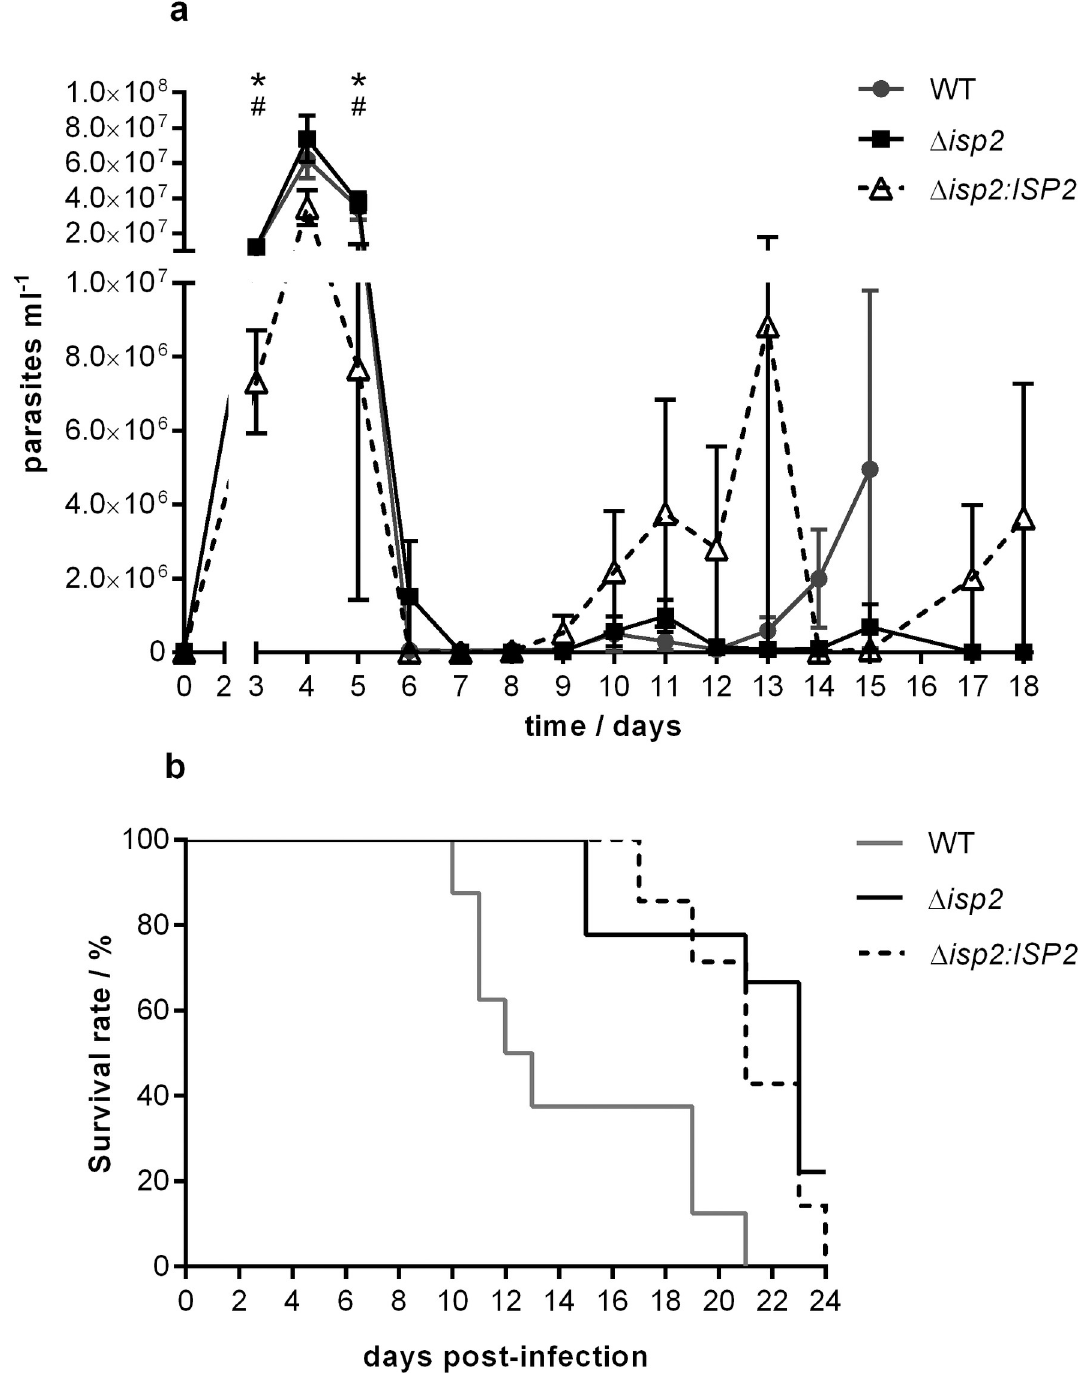
Fig 3. TbISP2 contributes to parasite virulence in mice. C57BL/6 mice were infected intraperitoneally with 1 × 10 5 T . b . rhodesiense WT, Δ isp 2 and Δ isp 2: ISP 2.(a) Parasitemia was calculated by counting the parasites in blood taken from the tail vein every day by microscopy from day 3 to day 18. Data are represented as the mean ± SEM (WT, n = 6 per group; Δ isp 2, n = 5 per group; and Δ isp 2: ISP 2, n = 6 per group).and are representative of three independent experiments. Statistical analysis was performed using Two Way ANOVA with Bonferroni post test. � p < 0.05 between WT and Δ isp 2: ISP 2, and # p < 0.05 between Δ isp 2 and Δ isp 2: ISP 2. (b) Survival curve of infected mice (n = 7–9 per group). Graph is representative of two independent